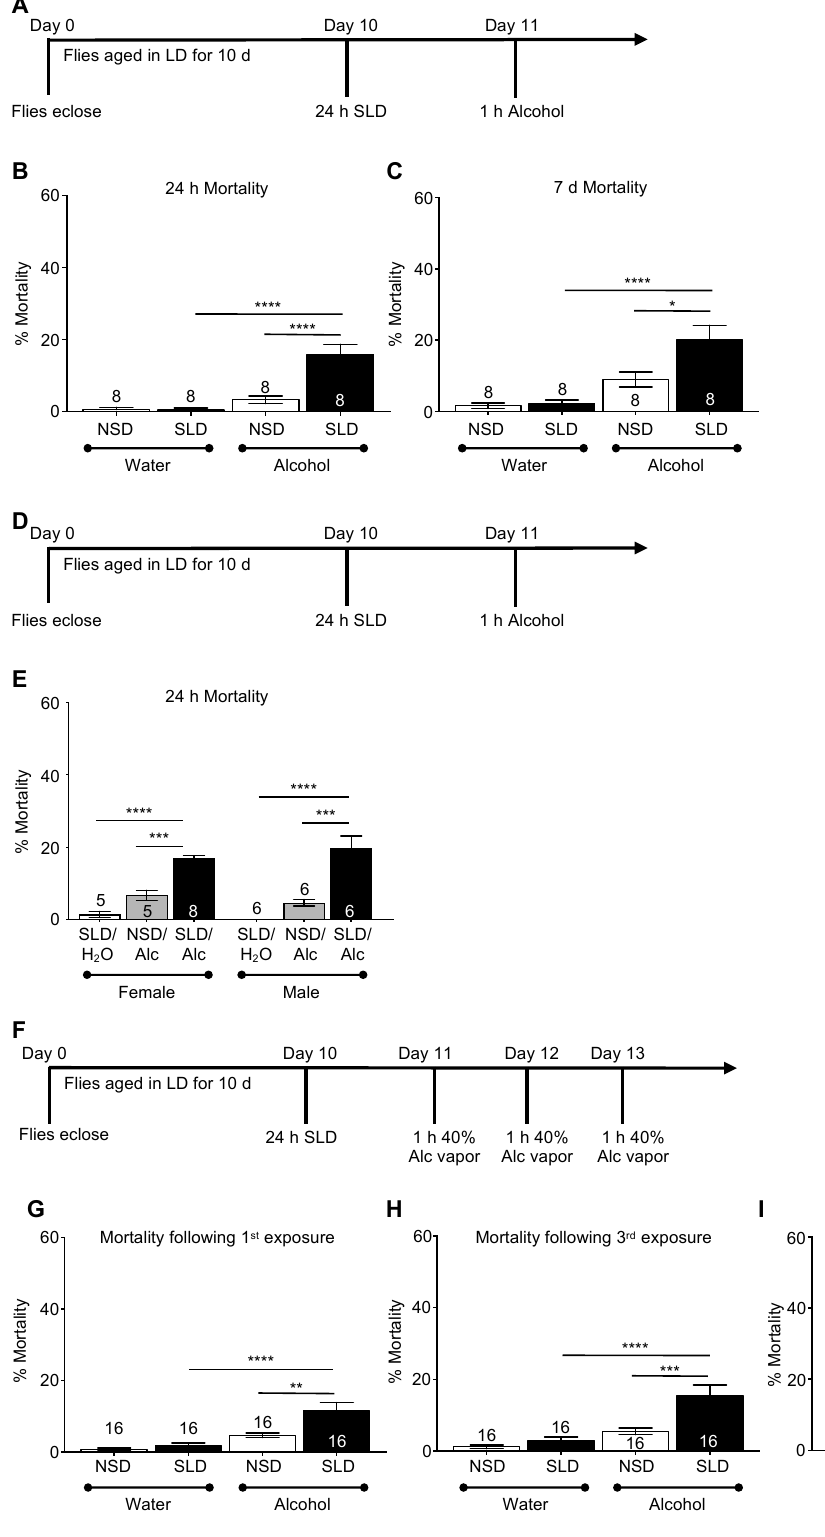
Figure 2. Acute sleep deprivation exacerbates alcohol-induced mortality following single or repeated exposure to alcohol. ( A ) Wild-type CS 10 d old flies were sleep deprived for 24 h and then exposed to 50% alcohol vapor for 1 h with mortality assessed every 24 h. ( B ) Sleep-deprived flies exhibited a significant increase in mortality within 24 h of exposure to alcohol compared to non-sleep-deprived flies (ANOVA F 3,28 = 22.50, p < 0.0001). ( C ) Mortality differences remained apparent at 7 d after